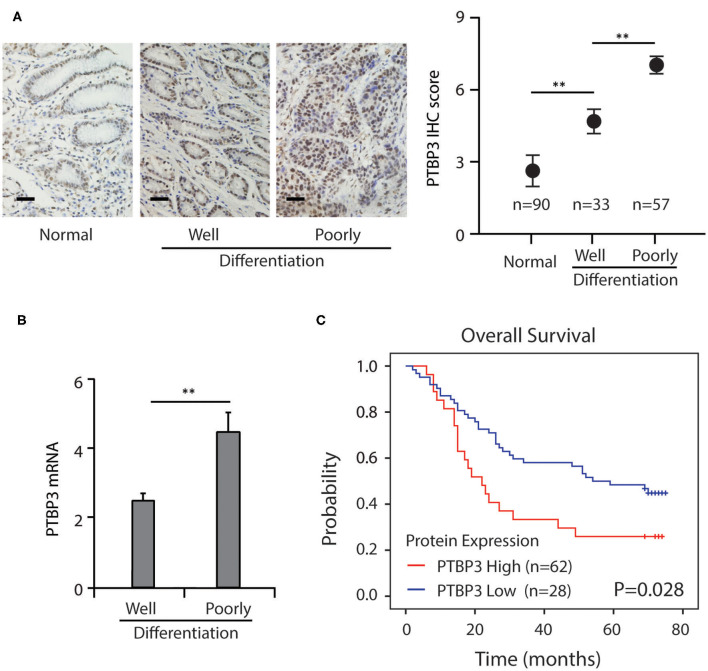
Increased PTBP3 expression was associated with poor survival in gastric cancer. (A) Representative images and quantitative IHC analysis of PTBP3 expression in normal gastric mucosa tissue, well and poorly-differentiation of gastric cancer tissue. Scale bar, 50 μm. (B) PTBP3 mRNA levels (log2 intensity) in well and poorly-differentiation of gastric cancer tissue. (C) Kaplan–Meier analysis of overall survival in patients with variable PTBP3 expression. *P < 0.01.